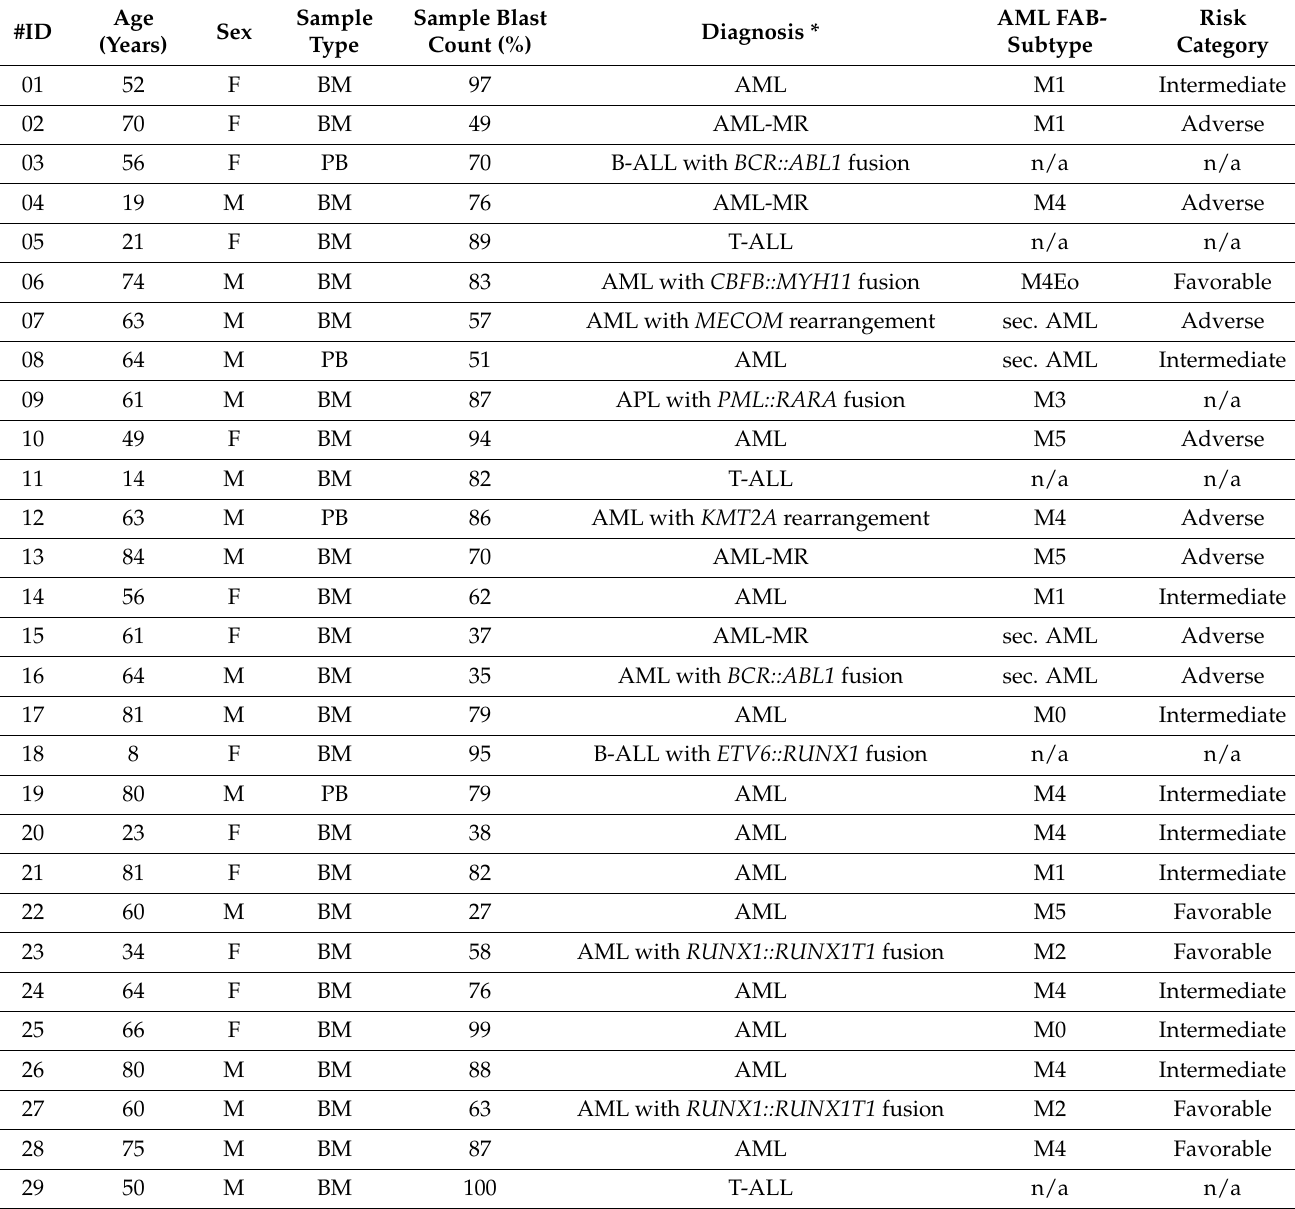
Table 1. Patient characteristics, source of sample and percentage of blasts, type of leukemia according to the WHO classification, subtype of AML according to the FAB classification, and risk category according to the ELN classification.